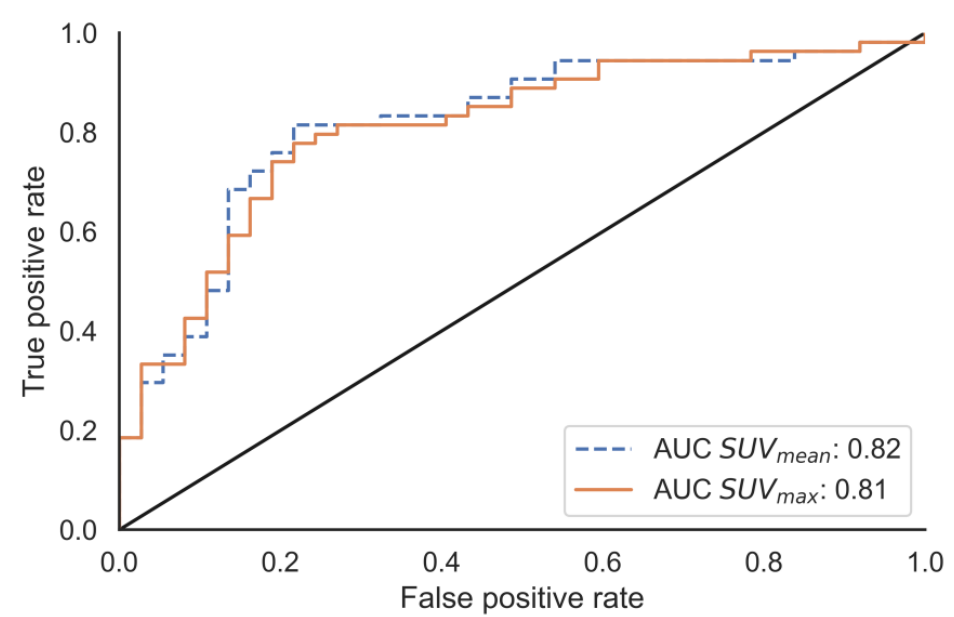
Figure 5. Receiver operating characteristic analysis. The ability to classify the absorbed dose as either above or below the test population median value of 3.0 Gy/GBq was tested.